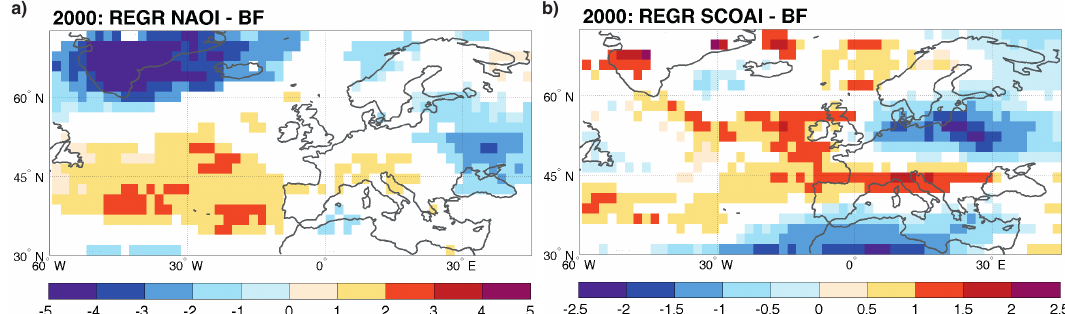
Figure 4. Blocking frequency anomalies (in % of days in which a blocking event occurs at a given gridbox) per unit of NAO index (NAOI, a ) and SCOA index (SCOAI, b ) standard deviation. The anomalies are calculated using a one-point regression analysis (see Appendix B). Only differences significant at 95% confidence level are shown (based on the correlation significance between NAOI/SCOAI and blocking frequency). Note that the two panels use different colour